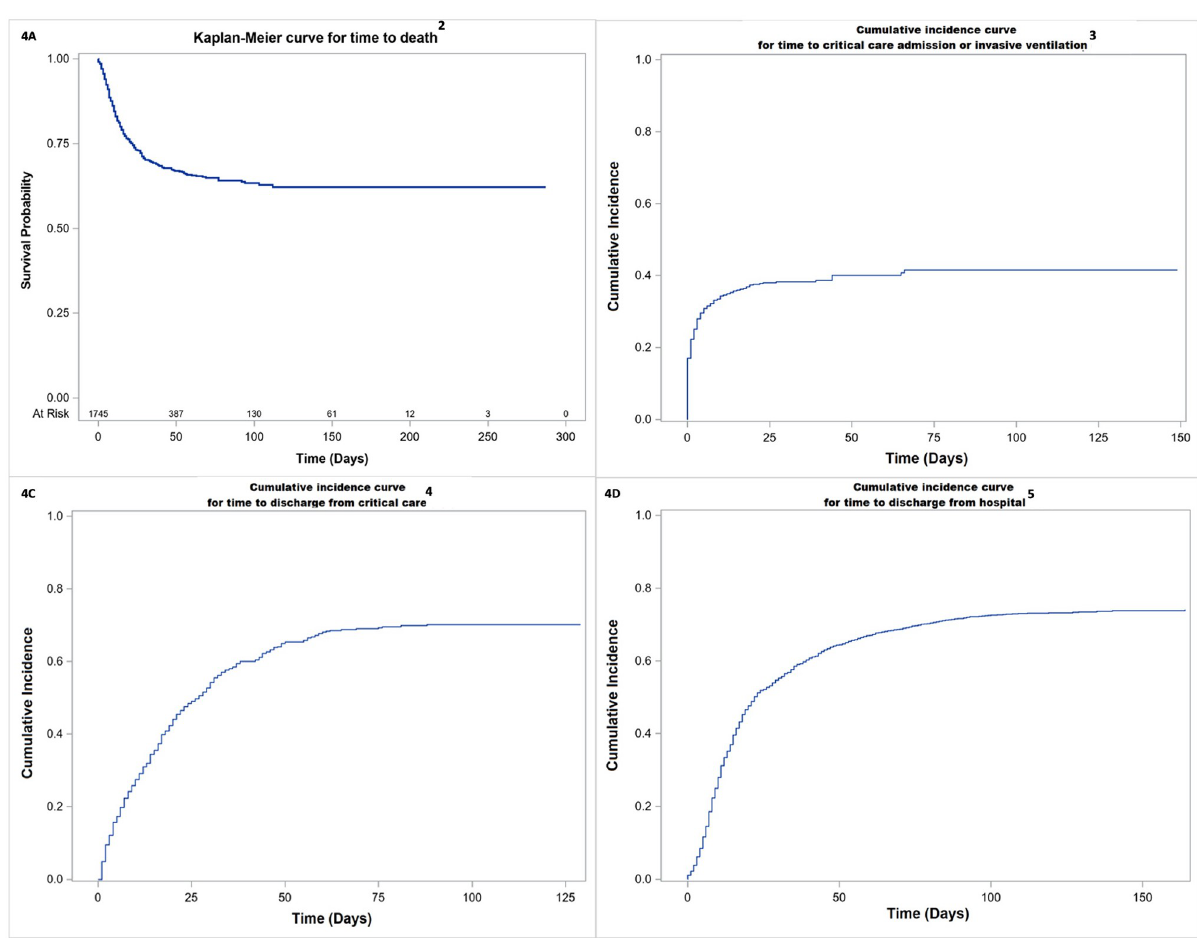
Fig 4. Time-to-event analyses for secondary outcomes for patients with COVID-19 and neurological disease in the IPD database 1 . 1. These figures show results of analyses for the whole IPD database (i.e., patients with any neurological disease diagnosis), and other than for A, the analyses use death as a competing risk. 2. A total of 1745 patients were included in this analysis. Of the 1979, 115 had no dates; 14 patients had no hospital admission date; 9 dead patients had no date of death; 88 alive patients had no discharge date; it was unknown if 8 patients were dead or alive. For time to death, individuals that were alive at discharge or last follow-up were censored. 3. This analysis uses date of hospital admission as day 0. A total of 1428 patients were included in this analysis: 404 patients had no dates; 17 had no hospital admission date; 123 (23 dead; 100 alive) patients had neither the date